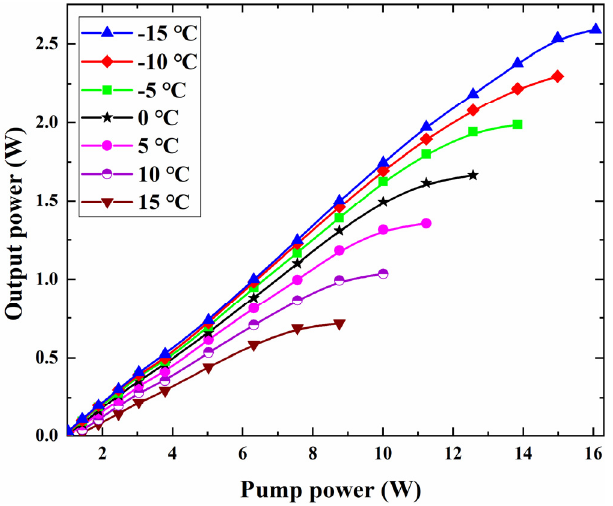
Figure 10. VECSEL output power curve for a transmission distance L 2 of 150 cm at different operating temperatures.